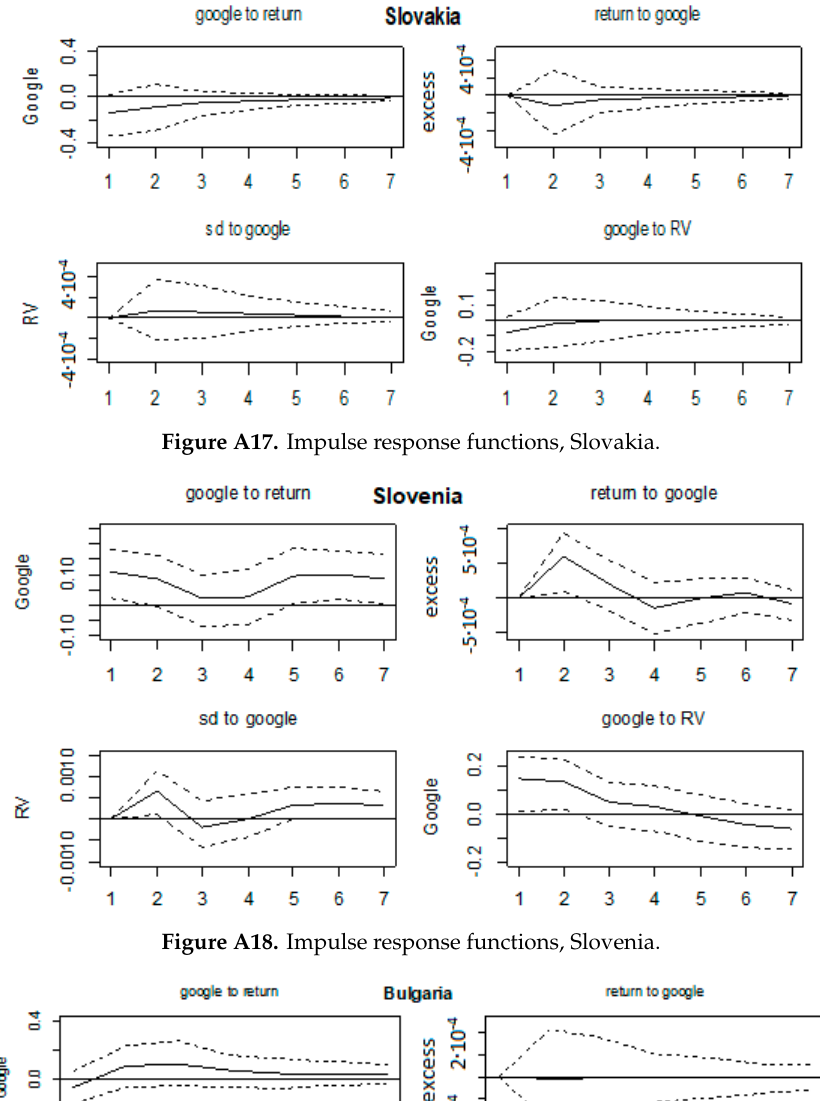
Figure A16. Impulse response functions, Czech Republic.